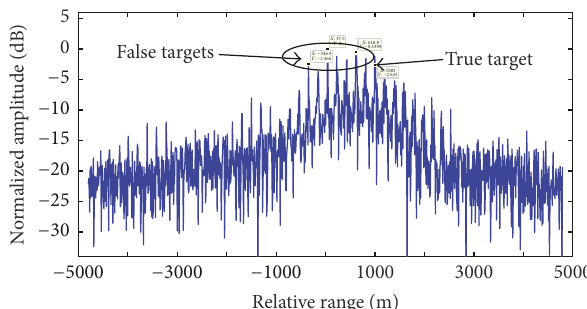
True targetFalse targets